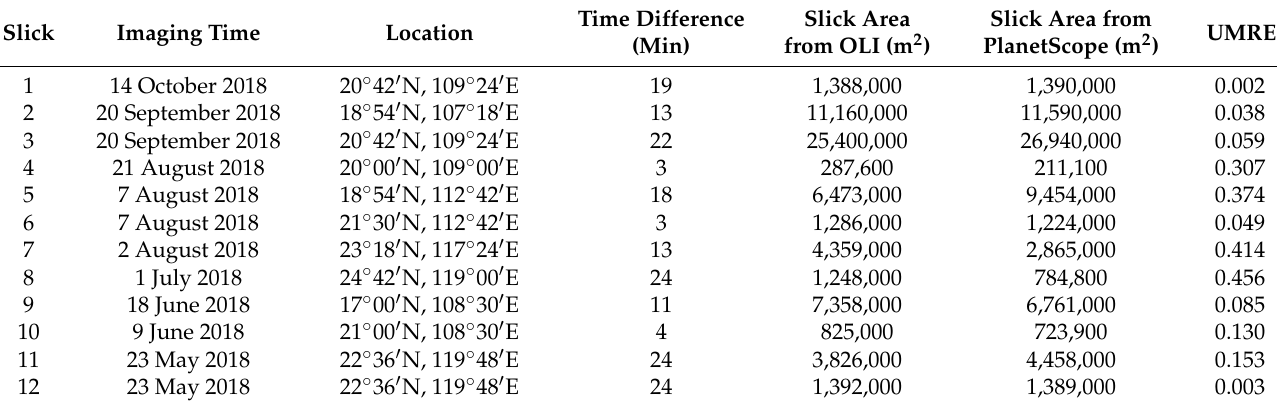
Table 4. Comparison of oil slick delineated results from the two